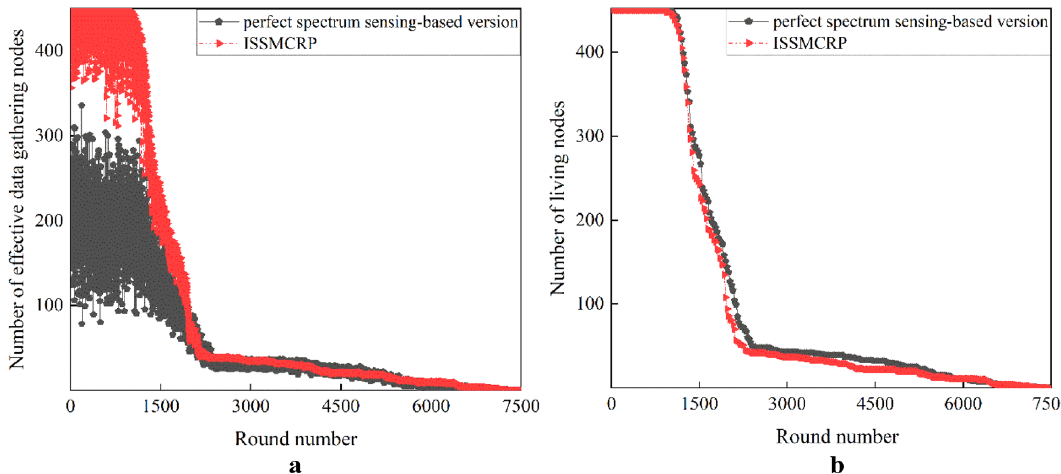
Figure 13. The necessity of taking the impact of imperfect spectrum sensing into consideration.